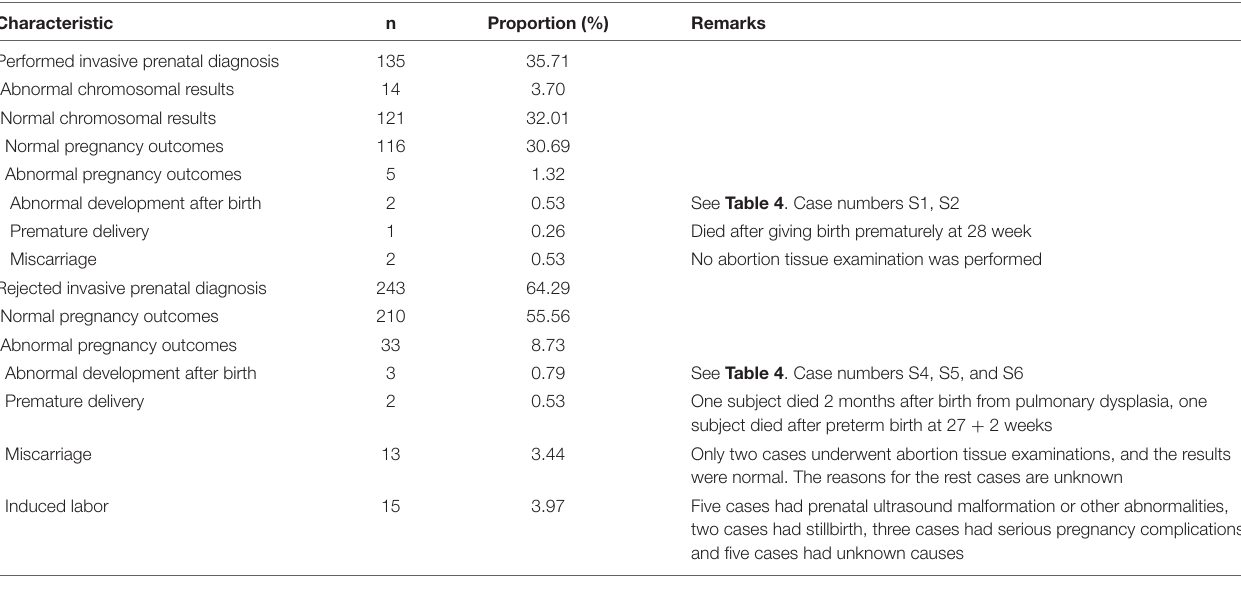
TABLE 3 | Prenatal diagnosis and pregnancy outcomes of 378 NIPS test failures (excluding lost-to-follow-up cases). Characteristic